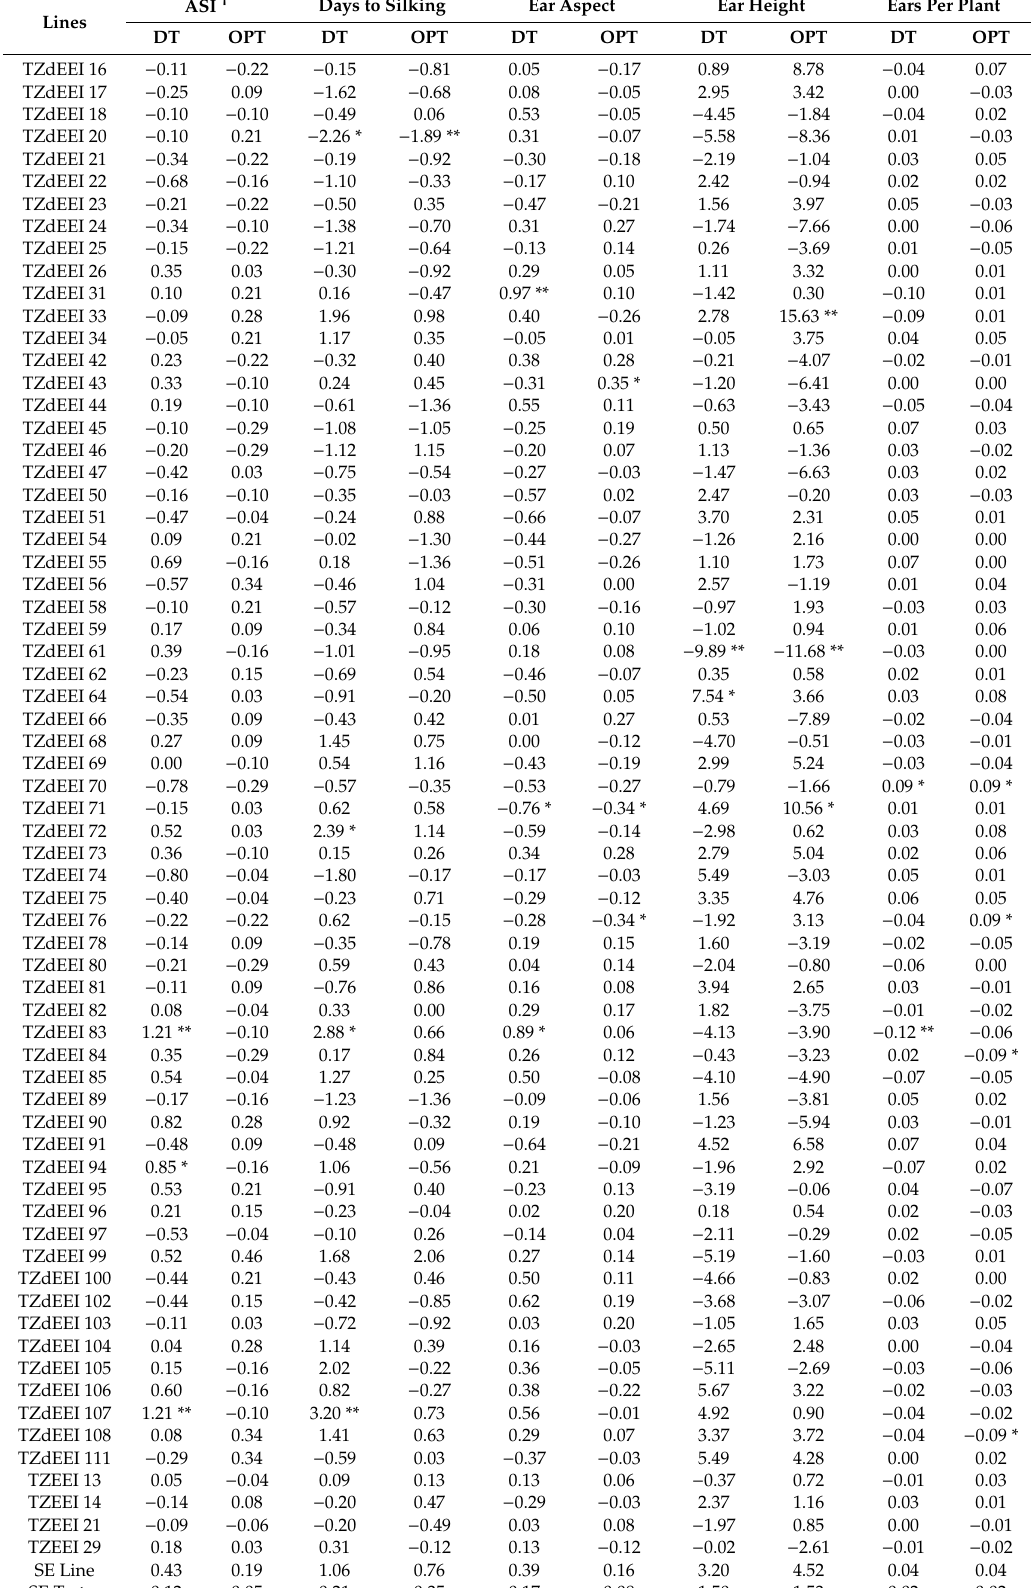
Table 5. General combining ability (GCA) e ff ects of lines and testers for grain yield and other agronomic traits under drought (DT) and optimal (OPT)